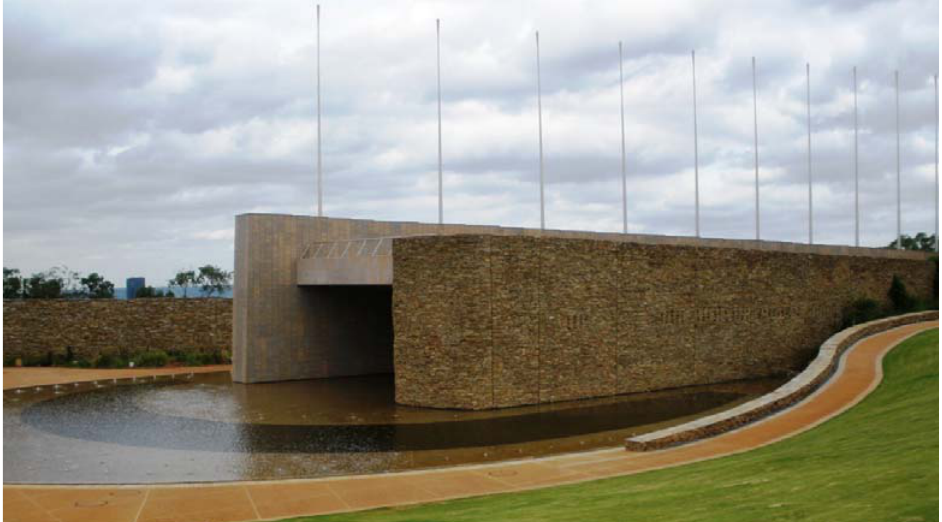
Figure 18. View of Sikhumbuto sanctuary with ‘reed’ poles in the background, Freedom Park, Pretoria (author’s